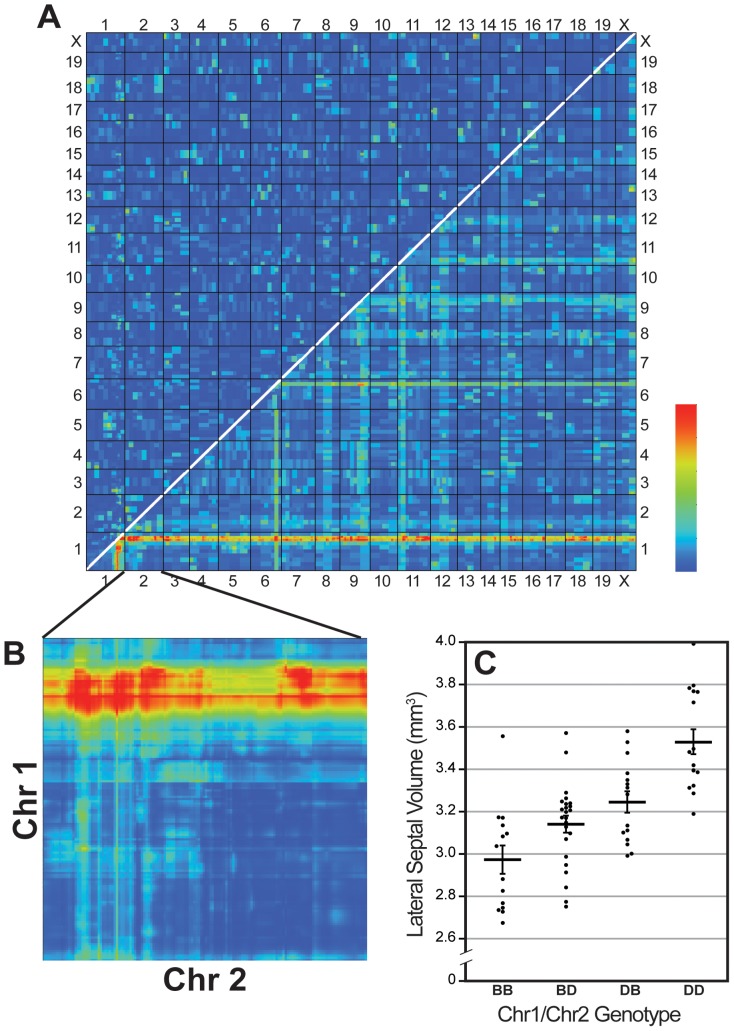
Pair-scan correlations demonstrate additive effect of QTLs on Chr1 and Chr 2.
A. Pair-scan analysis of adjusted LS volume (corrected for shrinkage, age, sex, epoch, and brain weight) across the genome. The upper left half of the plot highlights any epistatic interactions, while the lower right half provides a summary of LRS of the full model, representing cumulative effects of linear and non-linear terms. B. A significant interaction between QTLs on Chr 1 and 2 (white circle) is shown. C. Scatterplot (with means ± SEM) illustrating the effect on adjusted LS volume of carrying either the parental (D2) or maternal (B6) or both alleles at the Chr 1 and Chr 2 intervals. Having D2 alleles at both intervals significantly increases adjusted striatal volume when compared to all other allelic combinations.